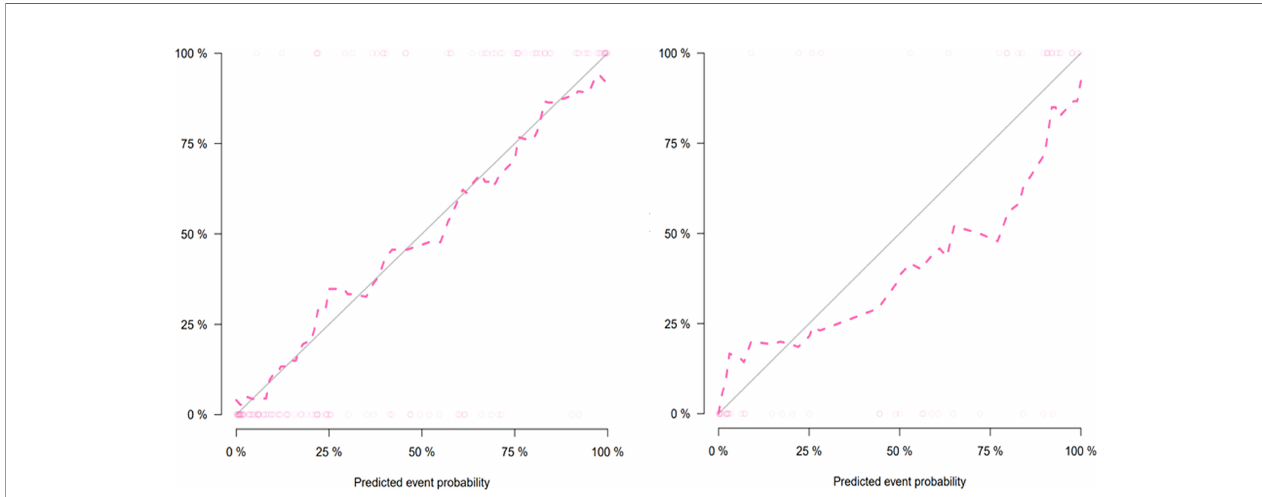
FIGURE 5 | Calibration curves of the nomogram for the training (left) and validation (right) sets. The y-axis and the x-axis show the actual rate of early recurrence (ER) and the predicted ER possibility, respectively. The solid diagonal line represents a perfect prediction. The closer the pink dashed line fi ts the solid line, the better the predictive ability of the model is.